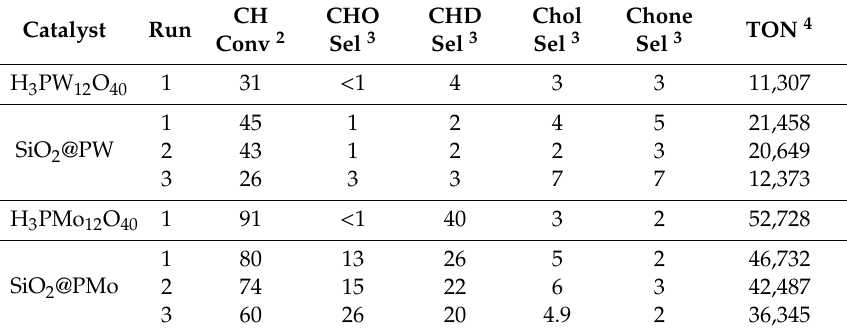
Table 4. Relevant data for the catalyzed (ep)oxidation of cyclohexene 1